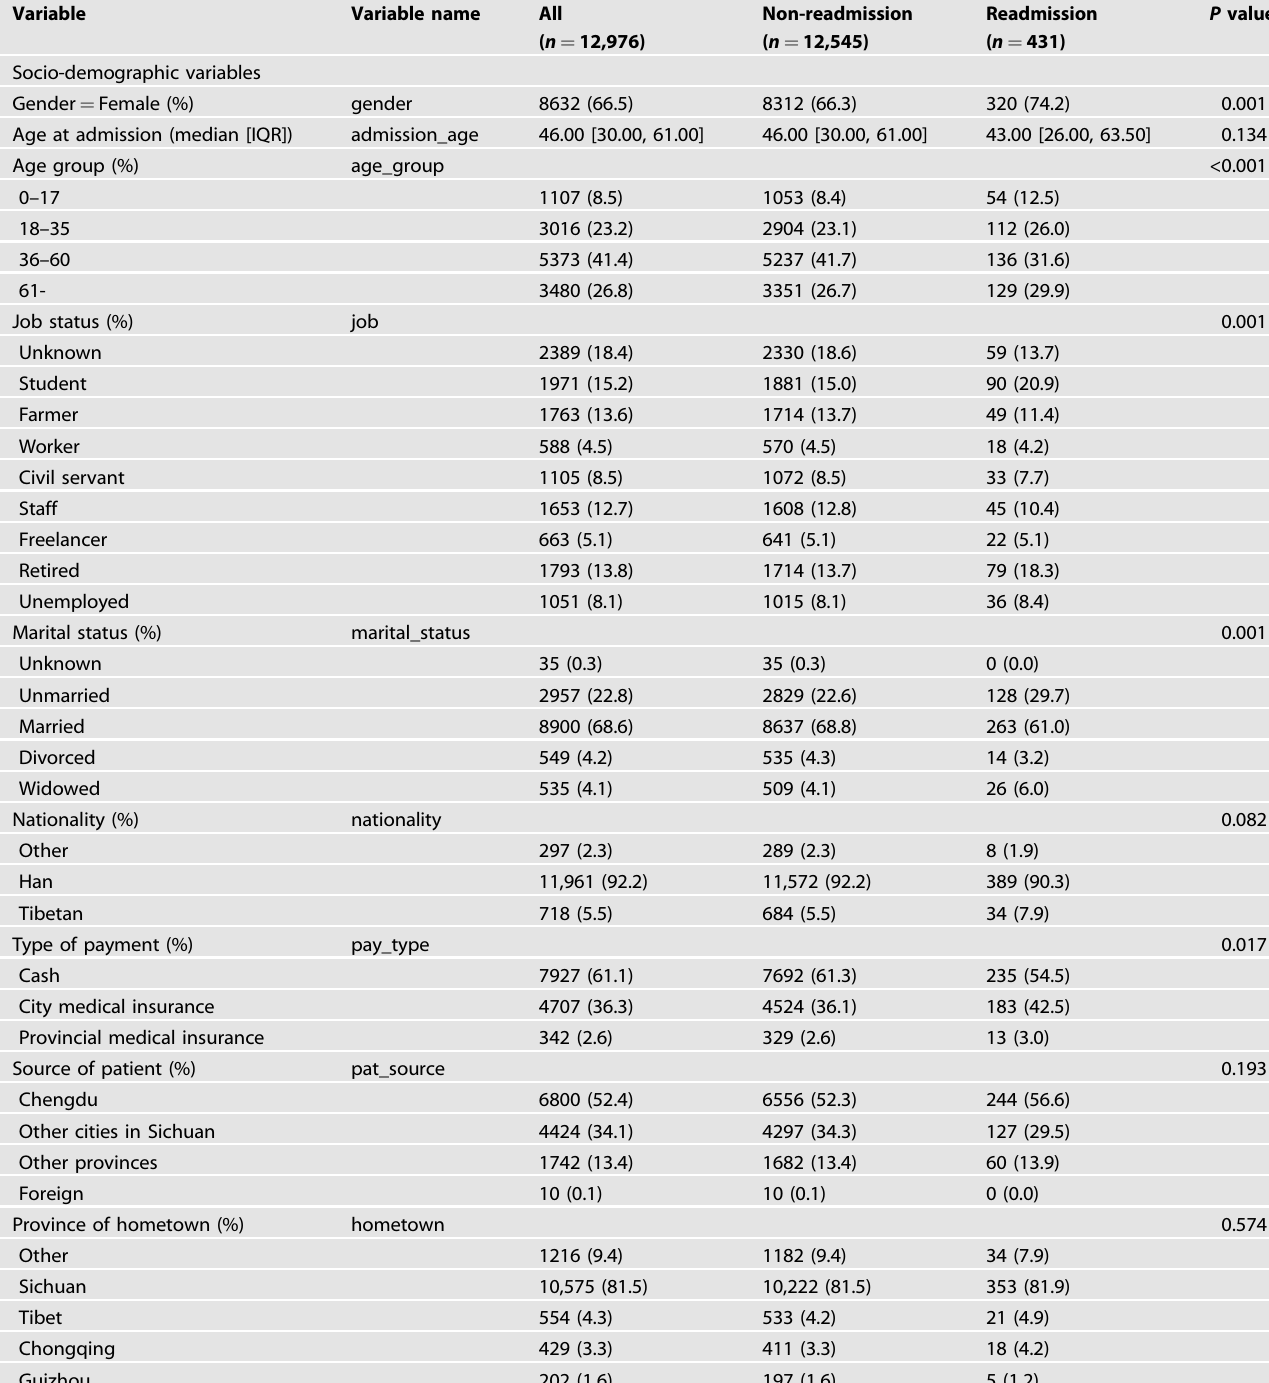
Table 1. Socio-demographic characteristics of the 30-day